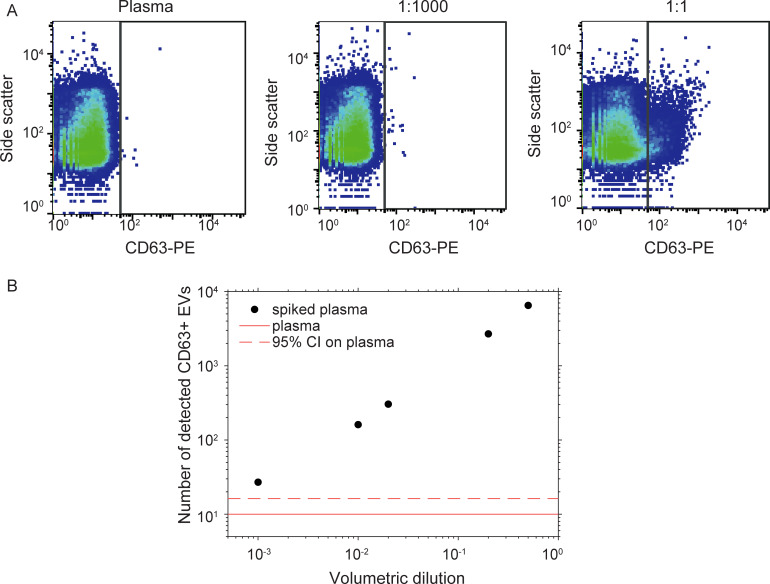
Spiking experiment to determine the minimal detectable marker+ particle concentration for flow cytometry.A) Side scatter versus CD63-PE fluorescence for pure plasma (left), plasma spiked with PC3 extracellular vesicles (EVs) at a 1:1000 volumetric dilution (centre) and 1:1 volumetric dilution (right). B) Detected number of CD63+ particles (black dots) at volumetric dilutions of PC3 EVs in plasma. CI: confidence interval.